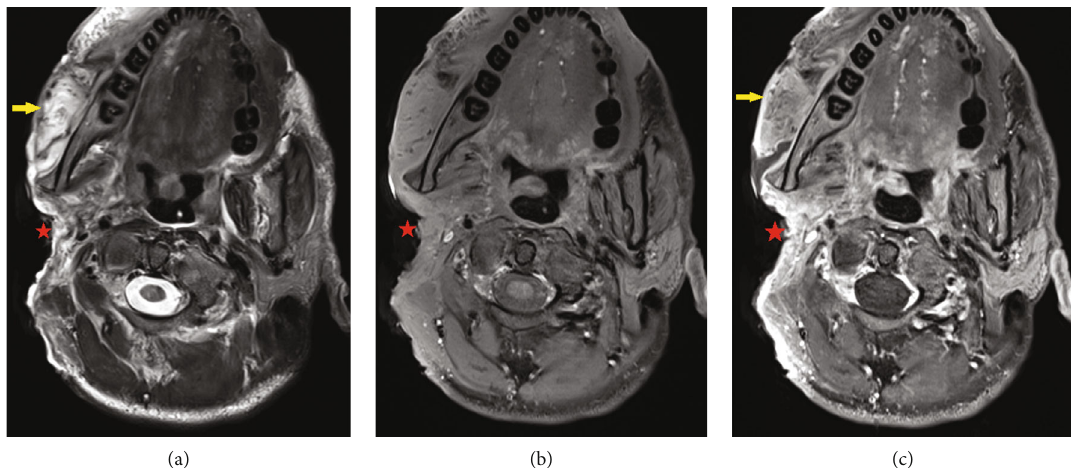
Figure 3: Axial MRI of the head showing postoperative outcome by after the fi rst stage of debulking with a drastic reduction in tumour tissue (red star). (a) T2-weighted imaging, (b) T1-weighted imaging, and (c) T1-weighted imaging after gadolinium injection. The masticator muscles show increased T2w intensity and di ff use enhancement, due to muscle oedema (yellow arrow). Residual tumour tissue is di ffi cult to di ff erentiate for which follow-up imaging is